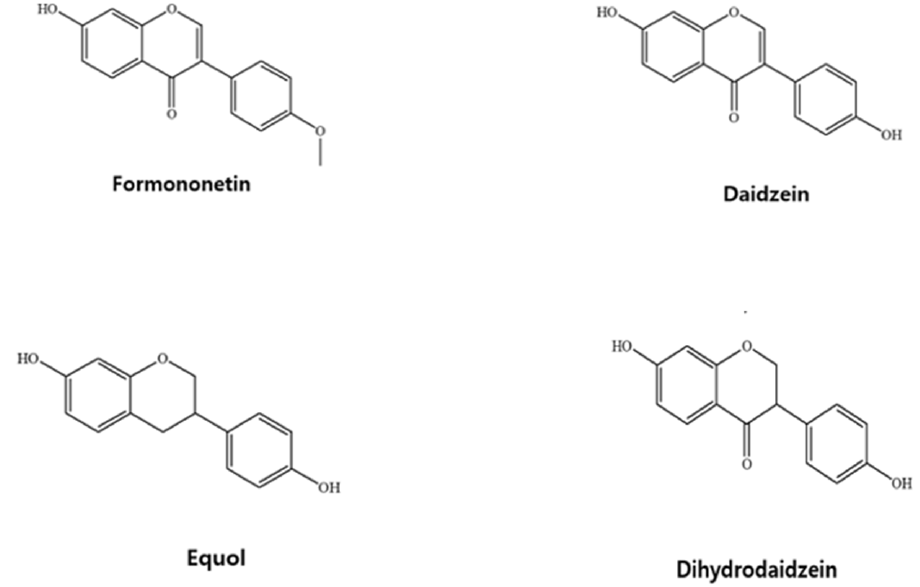
Figure 1. The chemical structures of FMN, DZN, EQL, and DHD. To the best of our knowledge, several analytical methods were reported to analyze FMN and/or other metabolites using HPLC-DAD [15], LC-MS/MS [16,17], and UPLC- MS/MS [18,19]. Among these, only one publication reported simultaneous analytical methods of FMN, DZN, DHD and EQL. Prasain et al. [16] have developed a rapid two- minute LC-MS/MS method that allowed quantification of 11 phytoestrogen metabolites, including the four isoflavone of our interest, in human plasma. However, the method required using 200 µ L of human plasma sample. This method cannot be adapted in rat experiment since only 50–100 µ L rat plasma per time point can be collected. Therefore, a simultaneous UPLC-MS/MS method for the more sensitive and rapid determination of FMN, DZN, DHD and EQL using minimal plasma was developed for the pharmacoki- netic